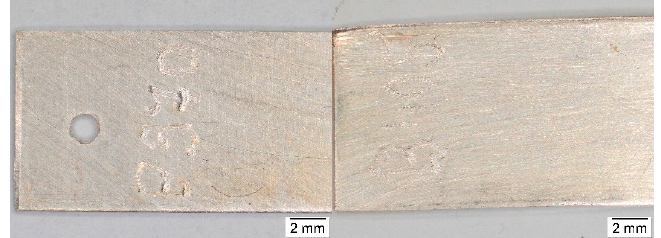
Figure 1. Total color differences of silver corrosion coupons after 1–30 months of exposure.